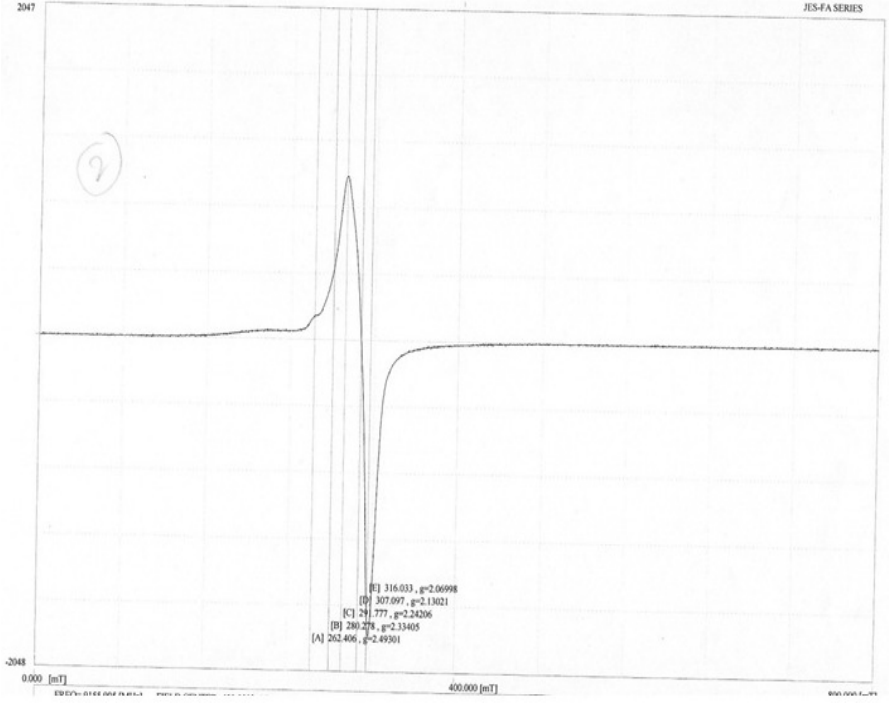
Figure 4. ESR spectra of Cu(II)